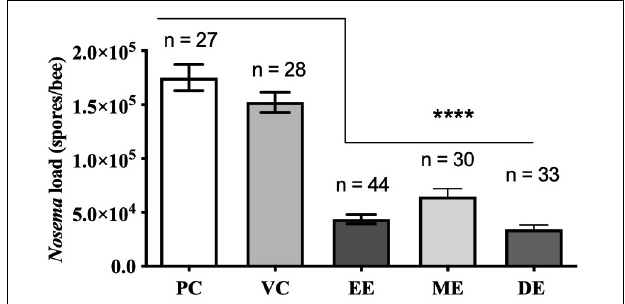
FIGURE 1 | Honey bee N. ceranae spore levels 4 days post inoculation (dpi; 2 × 10 5 spores) following feeding infected worker bees with maximum soluble concentrations of Upstate New York propolis (UNYP) extracts. Individual animals were fed ad libitum ethanol extract (EE; 5.9 g/l), methanol/water extract (ME; 13.8 g/l), DCM extract (DE; 2.6 g/l), positive control (PC), or vehicle control (VC). Each bar represents the mean ± SEM and the number of bees in each treatment group is indicated (****indicates p ≤